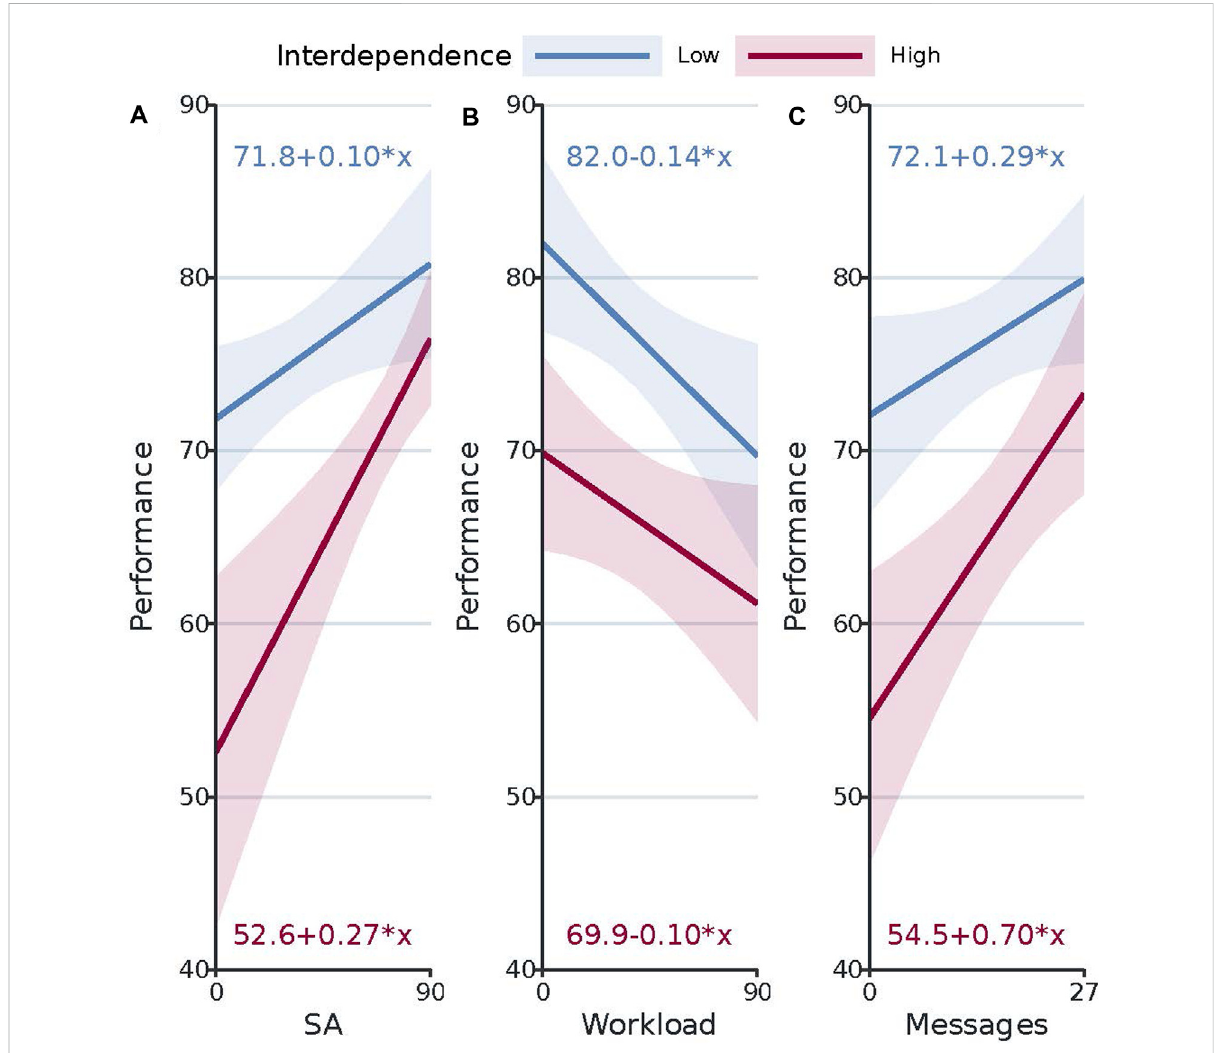
FIGURE 4 Predicted values of team performance based on the statistically signi fi cant predictor variables situation awareness (SA), workload, and human messages sent. Intervals represent the lower and upper bounds of the 95% con fi dence intervals for the predicted values. (A) shows the predicted changes in team performance with changes in the predictor variable situation awareness, at both interdependence levels. (B) shows the predicted changes in team performance with changes in the predictor variable workload, at both interdependence levels. (C) shows the predicted changes in team performance with changes in the predictor variable human messages sent, at both interdependence